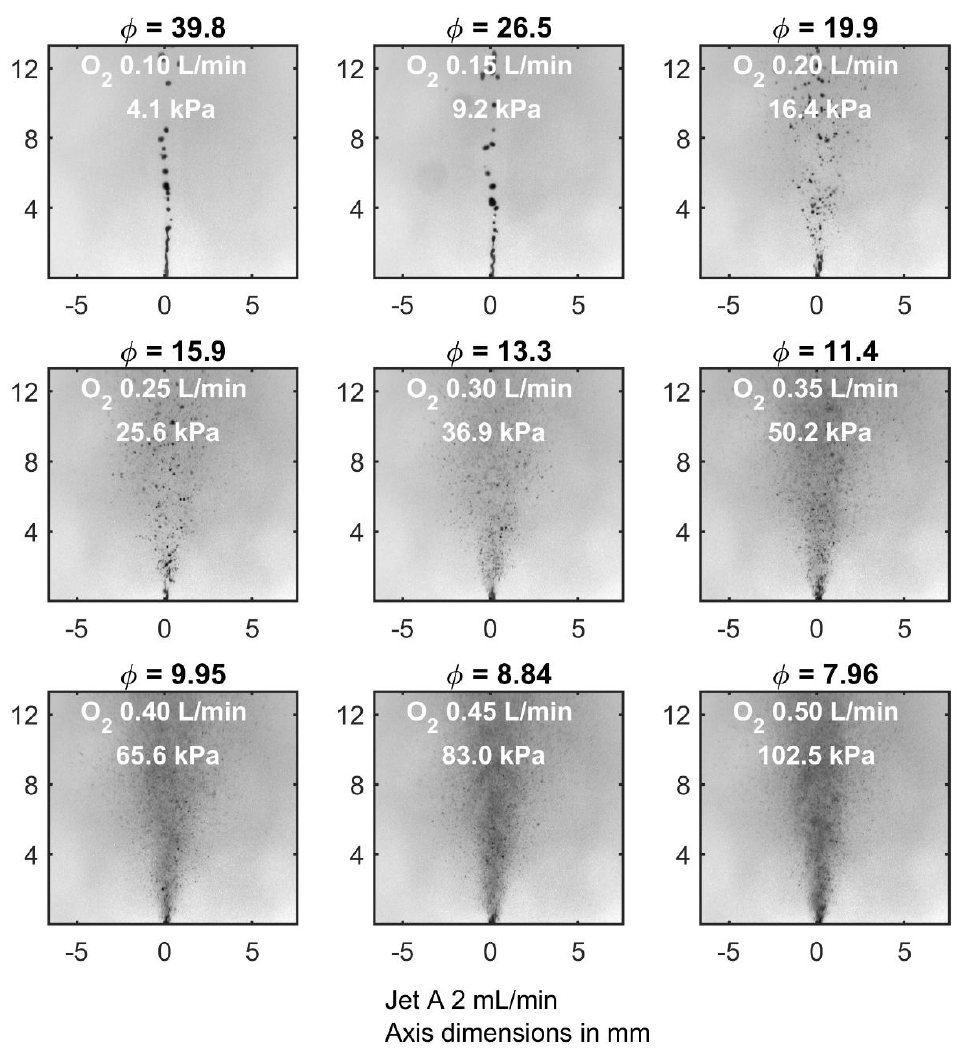
Figure 3. Shadowgraph images of Jet A spray at 2 mL / min fuel flow rate and variable oxygen flow rates. Calculated oxygen dynamic pressures and equivalence ratios are given.